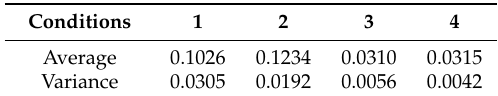
Table 6. Statistics of the results after calculating 20 times.